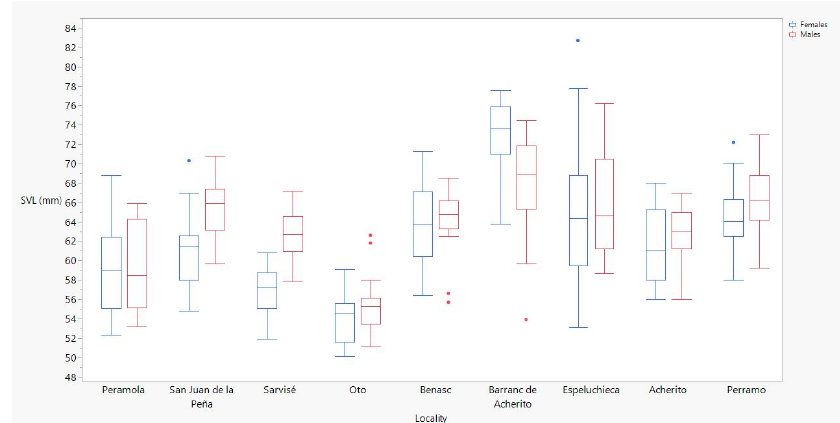
Figure 3. Box-plot of the snout-vent length of the newts for each locality and sex. The 1st Quartile (values up to the first 25% of sample) lower box limit and the 3rd Quartile (values up to 75% of sample) upper box limit. Vertical stripes outside the box identify the maximum and minimum values. The extreme cases are represented by circles.